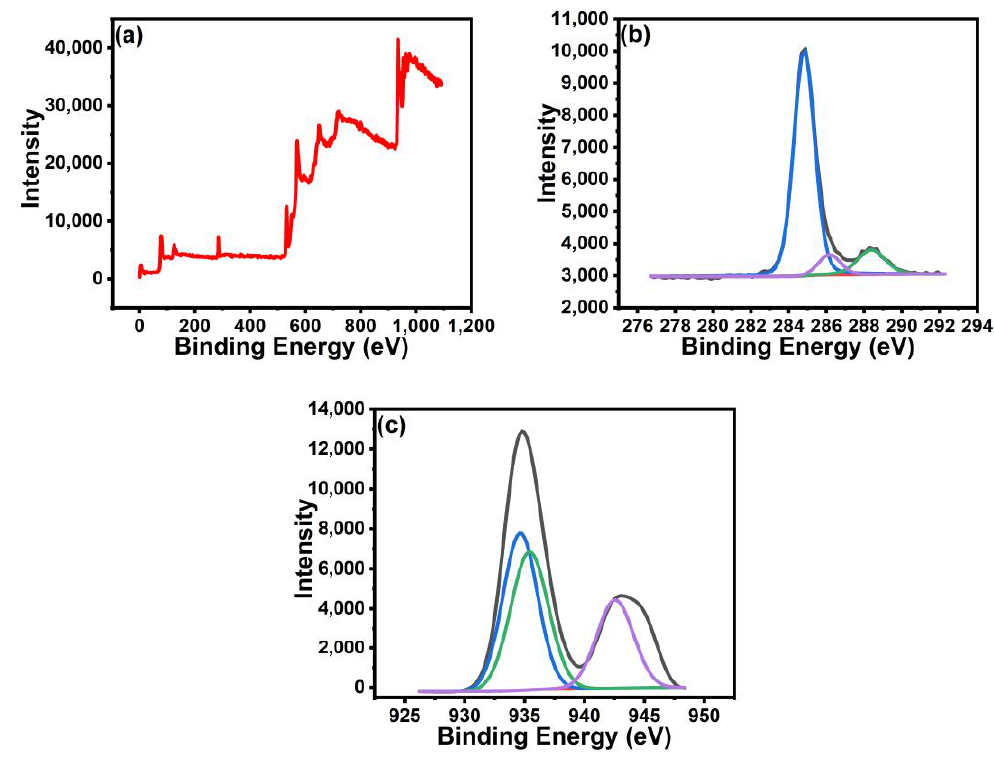
Figure 5. XPS spectra of GN@CR-Cu composite: ( a ) survey scan, ( b ) C1s, and ( c ) Cu2p3.